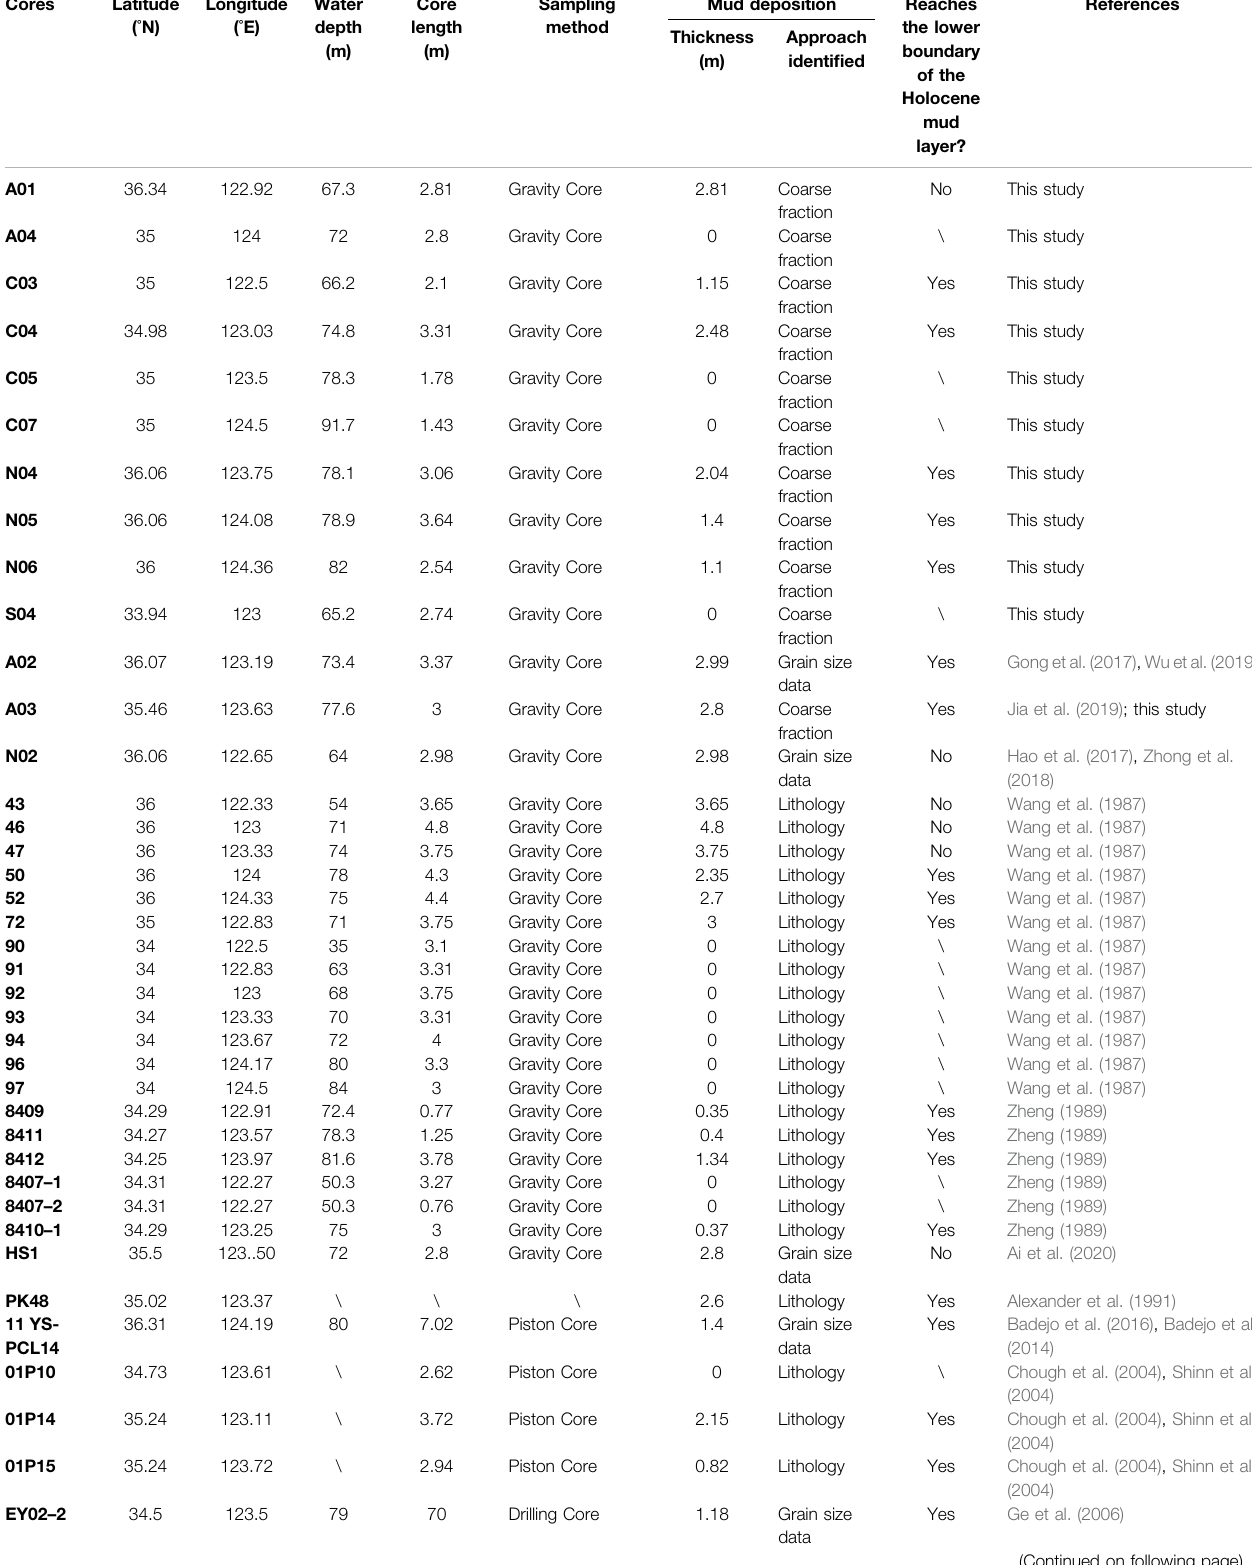
TABLE 1 | Sediment cores and paleoenvironmental reconstructions used in this study. Cores Latitude ( °